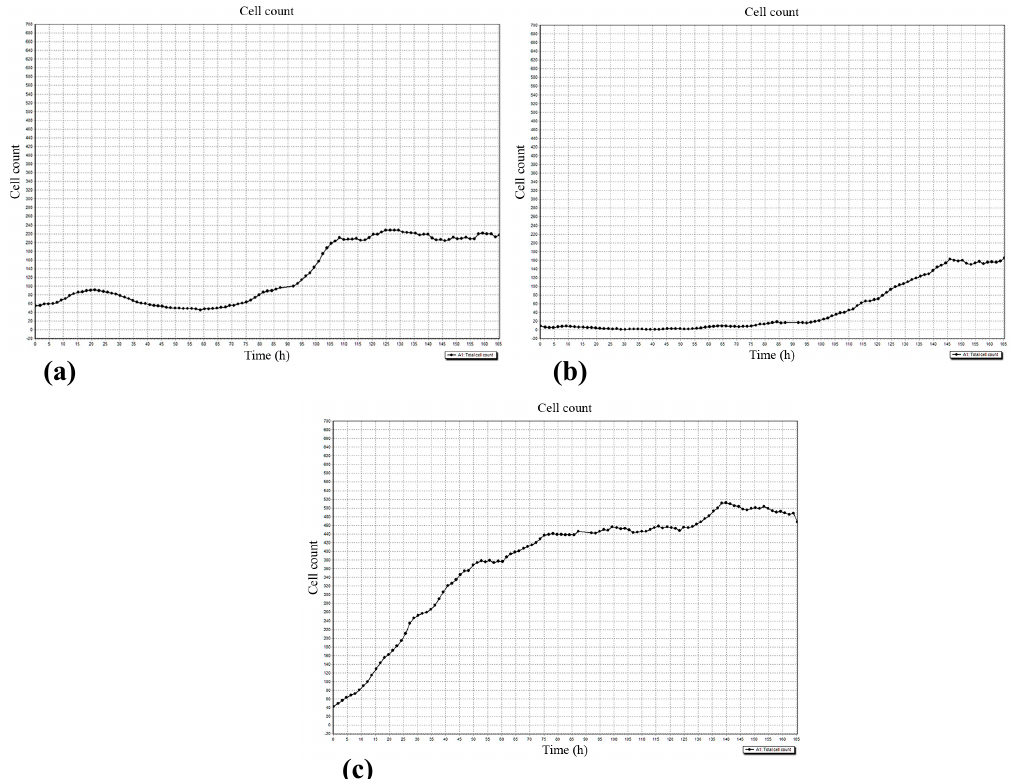
Figure 7. The dynamics of cell accumulation in the 5th visualization field (see Figure 1) of the Cell-IQ system. ( a ) hBMNCs; ( b ) hAMSCs in mixed cell culture; ( c ) hAMSCs in monoculture. X -axis: Observation time (h); Y -axis: Cell count.